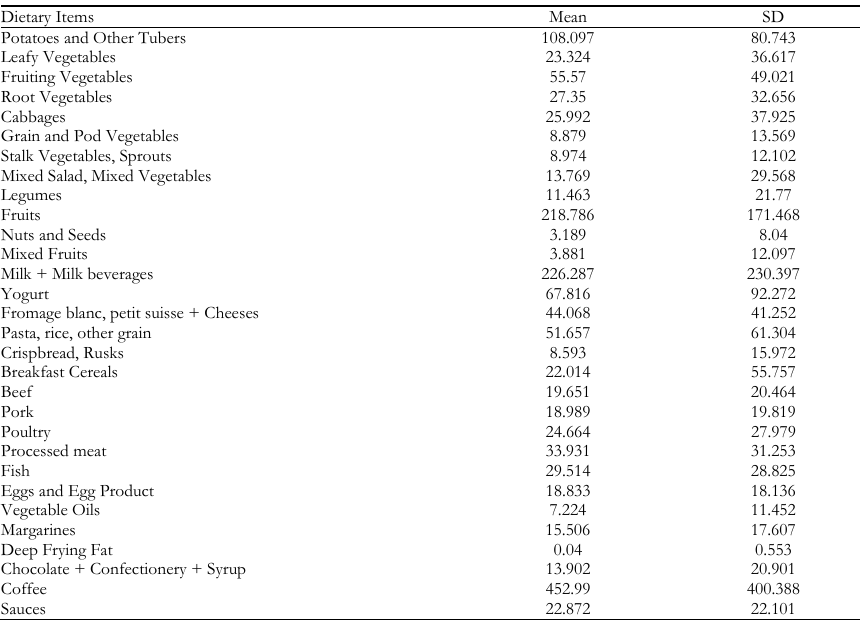
Dietary items and corresponding average intakes and standard deviations (gm/d) Dietary